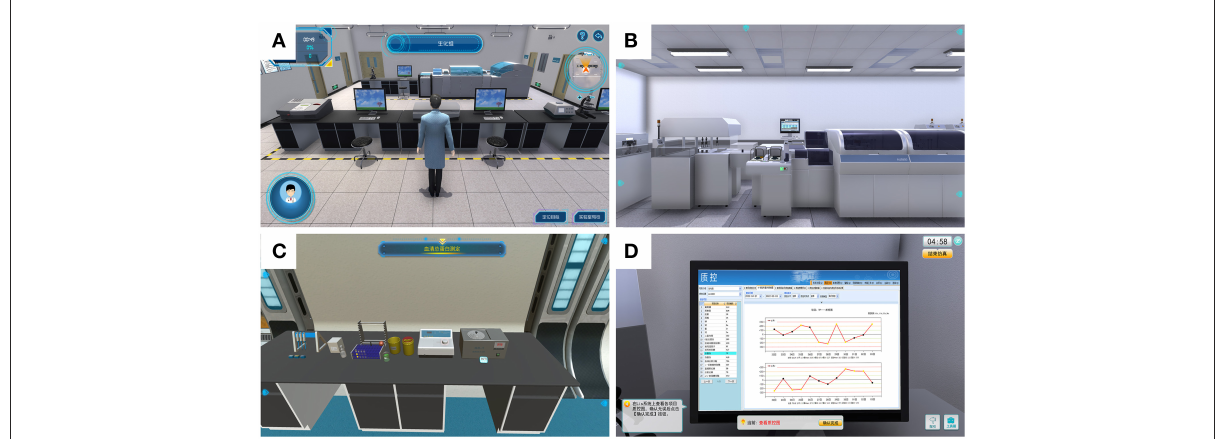
FIGURE1 Virtual simulation laboratory component of the operating interface. (A) Virtual clinical biochemistry laboratory. (B) Automatic biochemical analysis of the virtual simulation system. (C) Total serum protein and serum glucose determination. (D) Clinical biochemistry assay